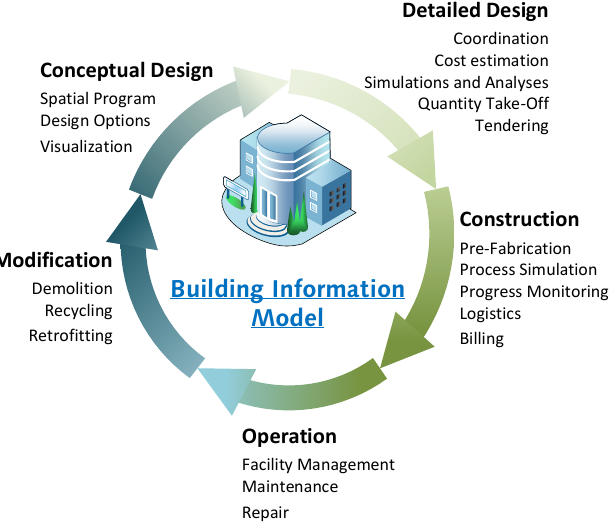
Figure 2. BIM in the life-cycle of a facility [13], according to